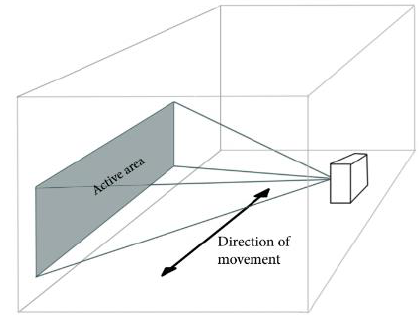
Figure 3 . Operational logic of the pedestrian radar module.